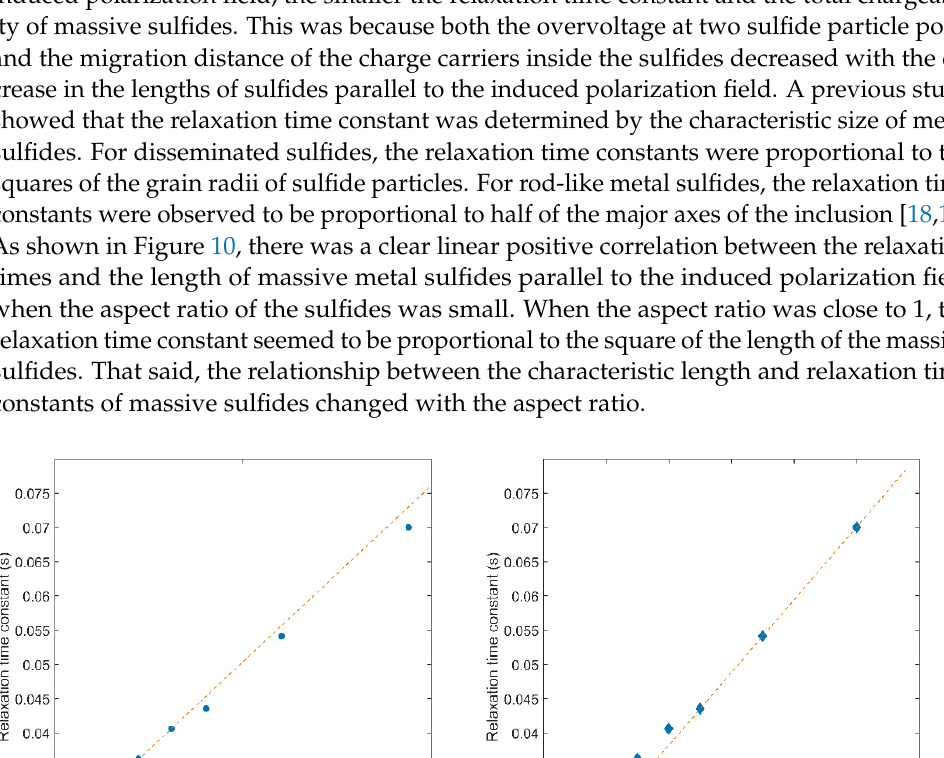
( b ) Figure 11. Influence of the tortuosities of vein metal sulfides on the migration of electrons during the induced polarization. ( a ) The numerical simulation results for the concentration distributions of